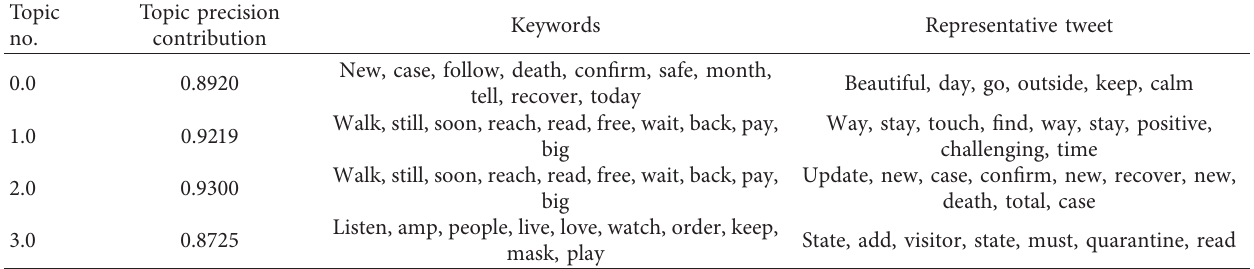
Table 3: Description of top four dominant topics.